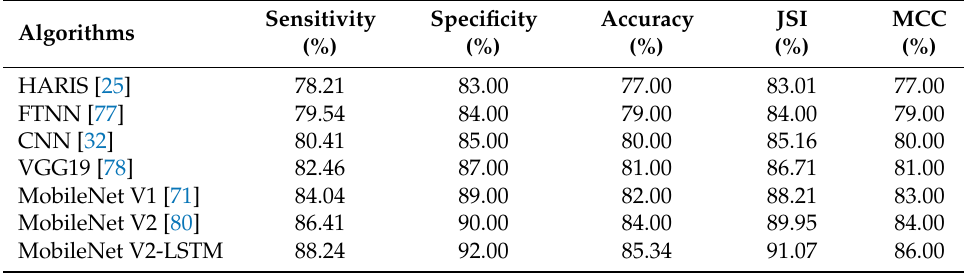
Table 3. The performance metrics of the various